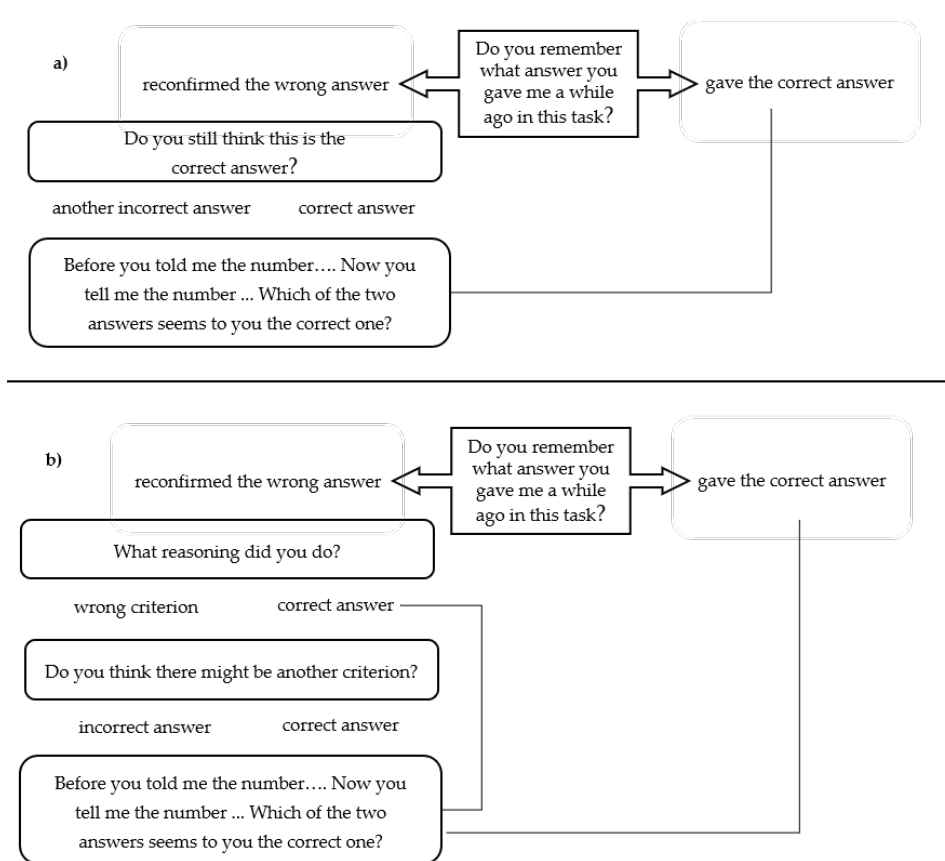
Figure 1. Flowchart of the standardized interview: ( a ) Factor III and Factor I and ( b ) Factor II.